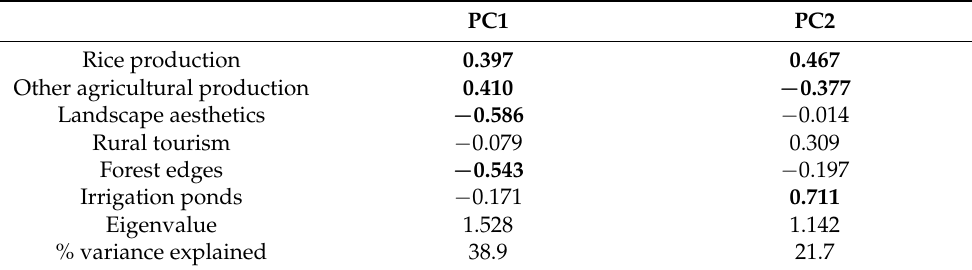
Table 2. Principal component analysis of agricultural ecosystem services and farmland biodiversity at the national level in Japan ( n = 1719). Results show PC loadings, eigenvalues, and the proportion of variance explained. Values in bold are the variables with the greatest weight in defining the two ordination